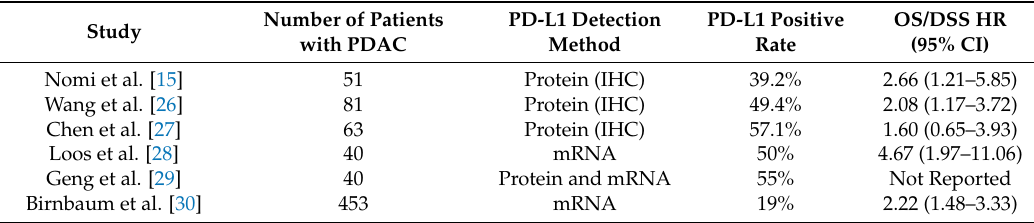
Table 1. Studies reporting programmed cell death protein-1 (PD-L1) expression rates and outcomes in patients with pancreatic ductal adenocarcinoma